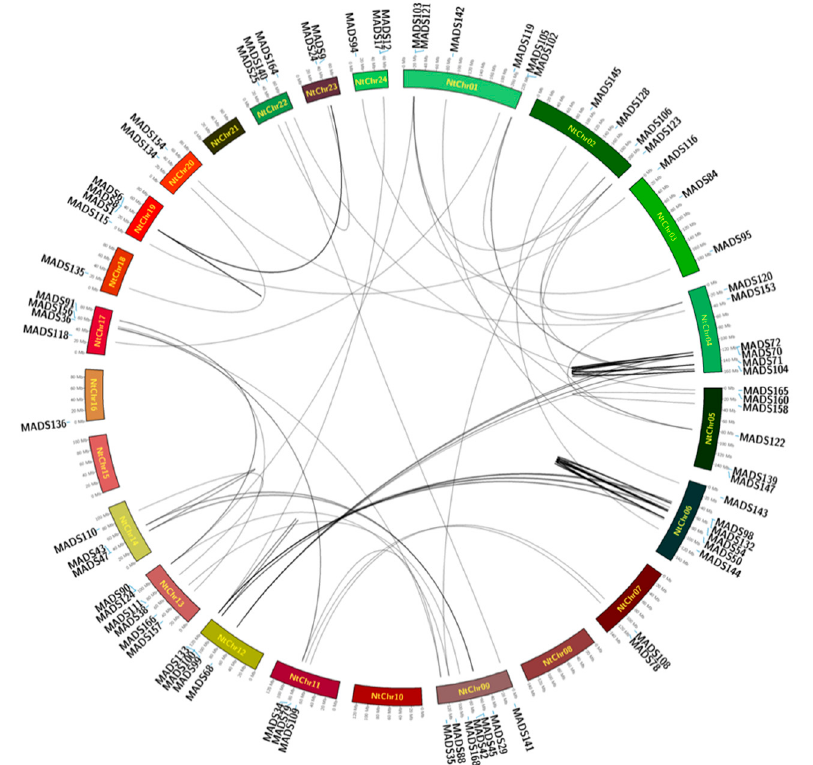
Figure 4. Collinear analysis of the NtMADS-box gene family in tobacco. The annulus represents the tobacco chromosomes, and the scale on the annulus is labeled in megabases (Mb). Homologous genes are linked by the lines. The figure was generated and modified using the Circos program.